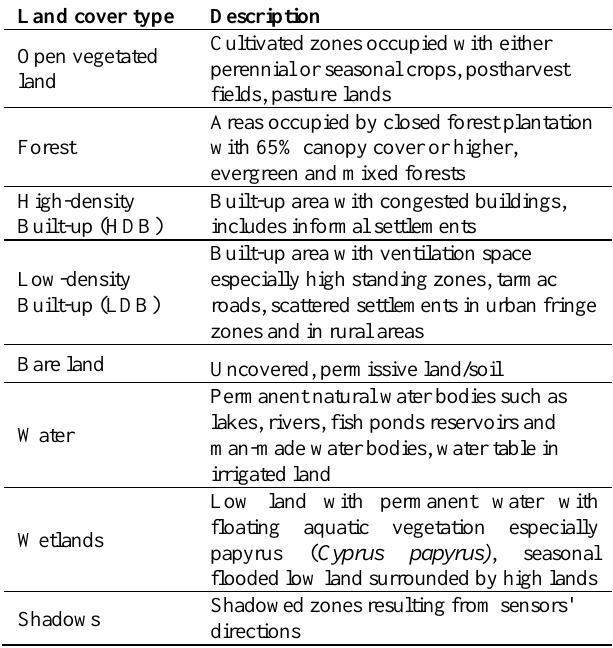
Table 1: Land cover class